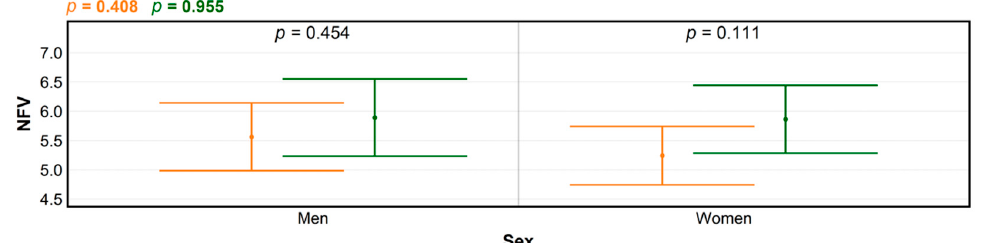
Figure 6. Levels of significance for differences in numbers of forest visits (NFV) between men and women, before (orange) and during the COVID-19 pandemic (green), produced using ANOVA; and for within-group NFV differences (black), determined by t -test.